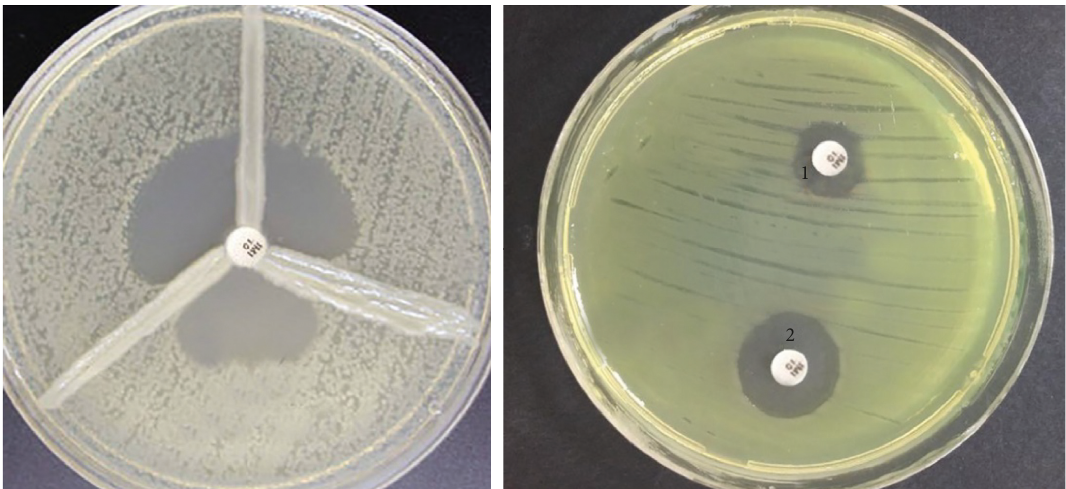
Figure 2: The result of phenotypic detection of MBL-producing Pseudomonas aeruginosa by the EDTA-imipenem microbiological (EIM) test in Pseudomonas aeruginosa . (a) EDTA +imipenem; (b) imipenem. Top: MBL positive strain; bottom: MBL negative strain; MBL considered positive when the zone diameter difference between imipenem+EDTA and imipenem discs was larger than 7mm (right). The result of phenotypic detection of carbapenemase-producing P. aeruginosa by the modified Hodge test